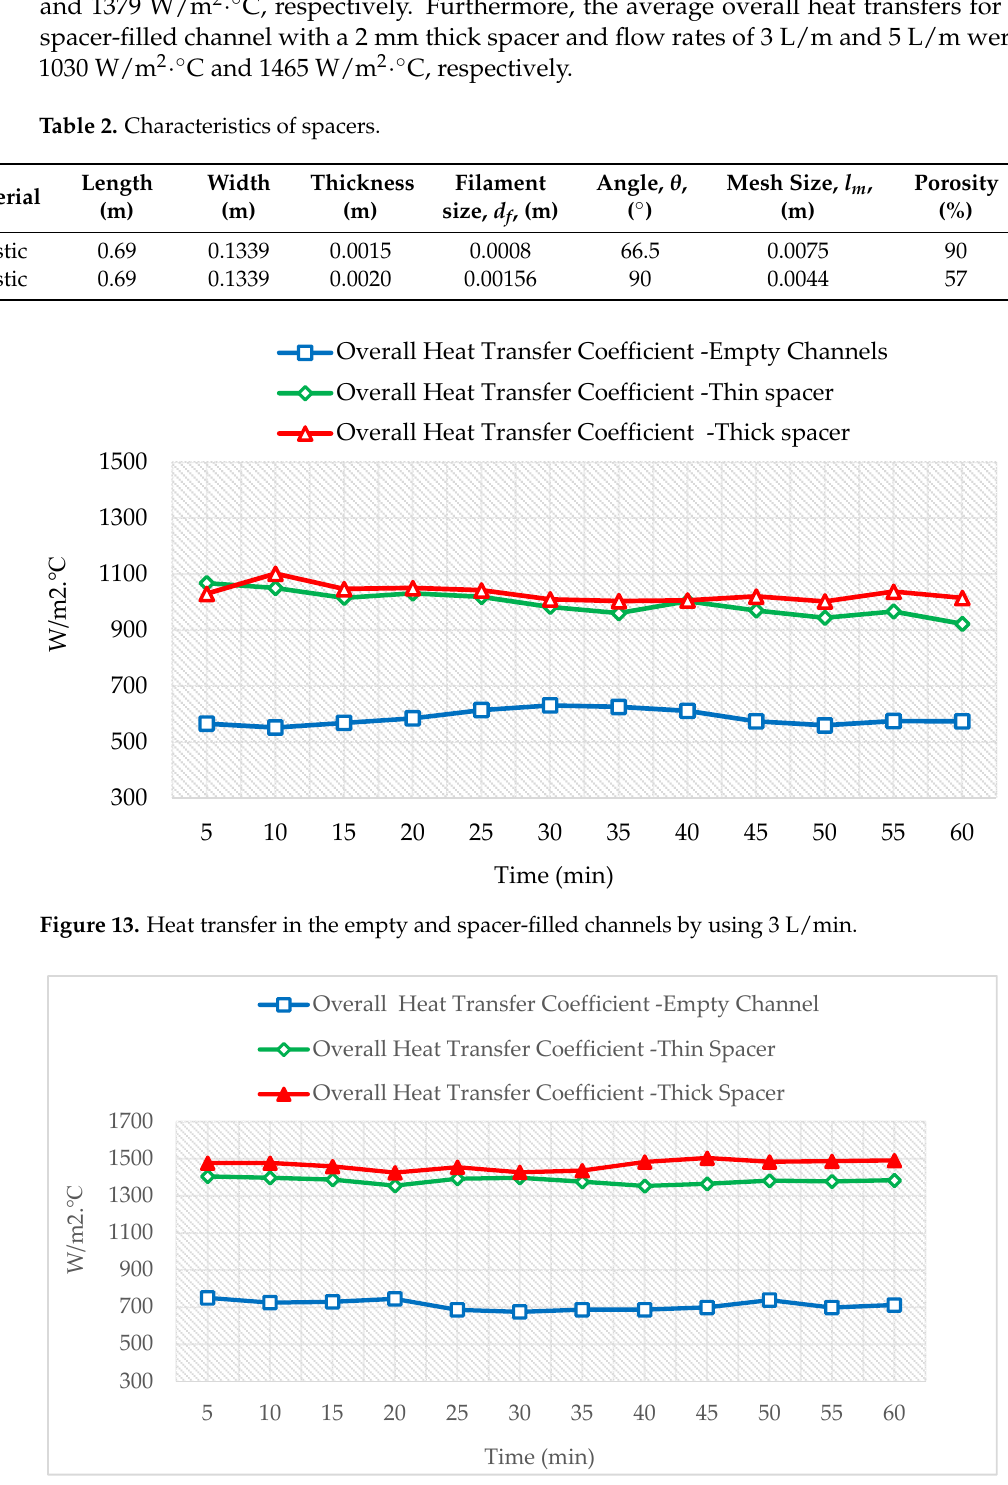
Figure 14. Heat transfer in the empty and spacer-filled channels by using 5 L/min.